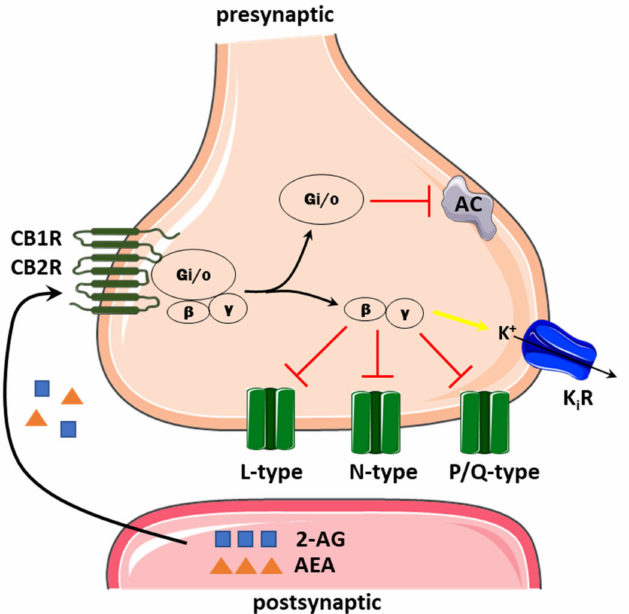
Figure 4. The schematic representation of endocannabinoid action on presynaptic Ca 2+ channels. Endocannabinoids synthesized postsynaptically act on presynaptic CB1/CB2 receptors coupled to Gi/o, which may decrease cAMP level by inhibiting adenylyl cyclase (AC). The βγ inhibits L, N and P/Q-type calcium channels but activates inwardly, rectifying the potassium channel (KiR, yellow arrow). Inhibitory action is indicated by the red